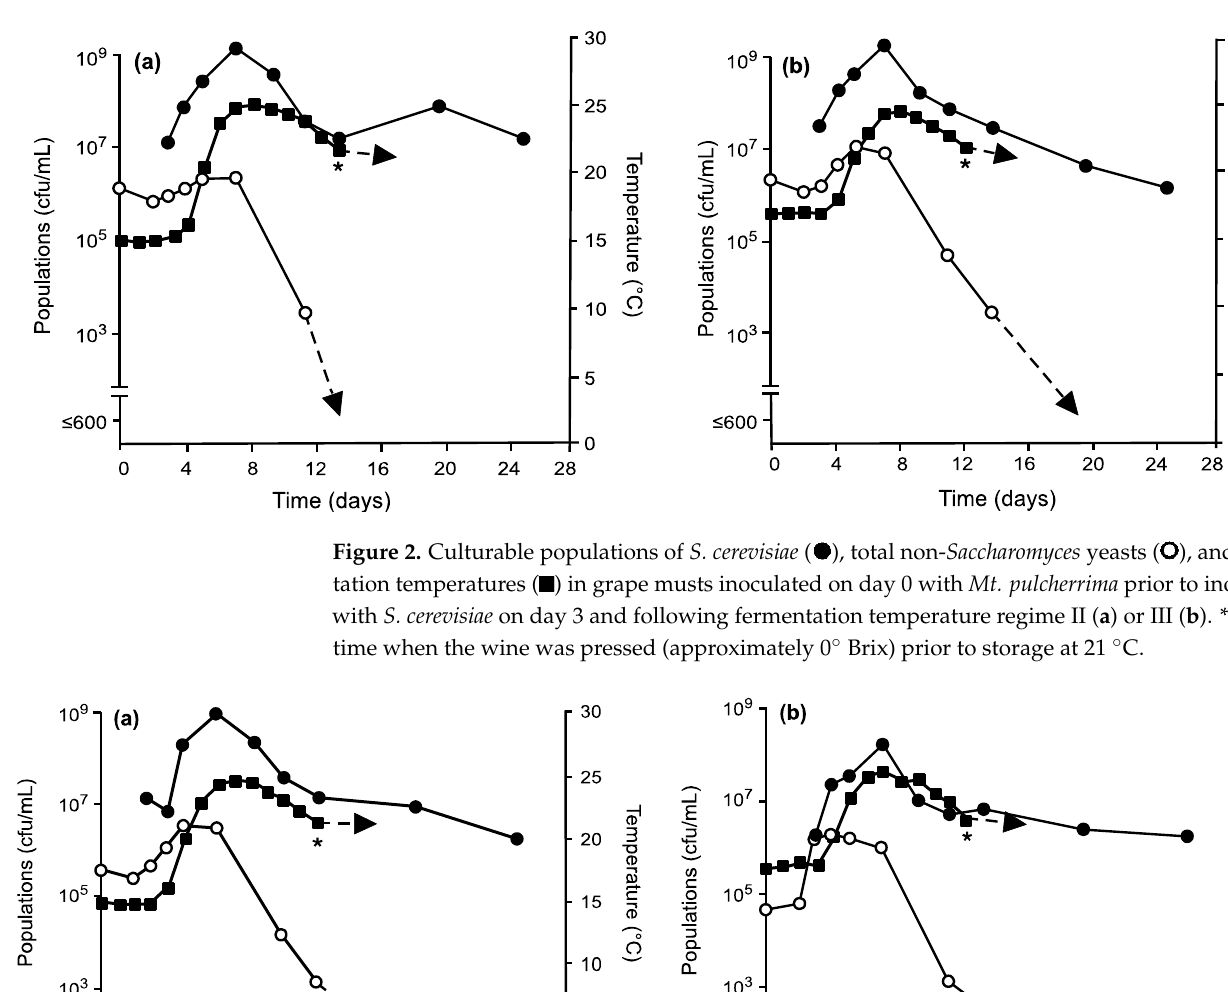
Figure 3. Culturable populations of S. cerevisiae ( ), total non- Saccharomyces yeasts ( ), and tem- peratures ( ) in grape musts inoculated on day 0 with My. guilliermondii prior to inoculation with S. cerevisiae on day 3 and following fermentation temperature regime II ( a ) or III ( b ). * Denotes time when the wine was pressed (approximately 0° Brix) prior to storage at 21 °C.